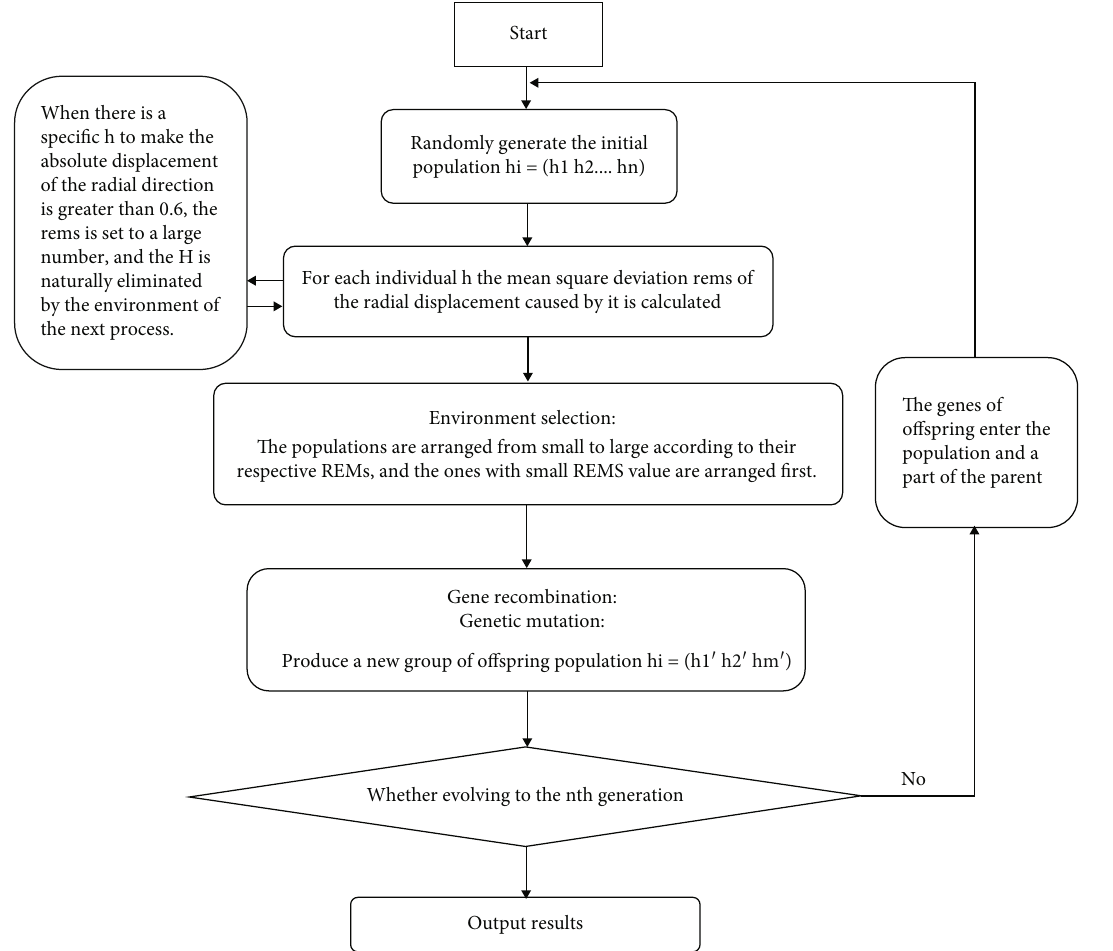
Figure 4: Schematic diagram of the rotation of the space follow-up coordinate